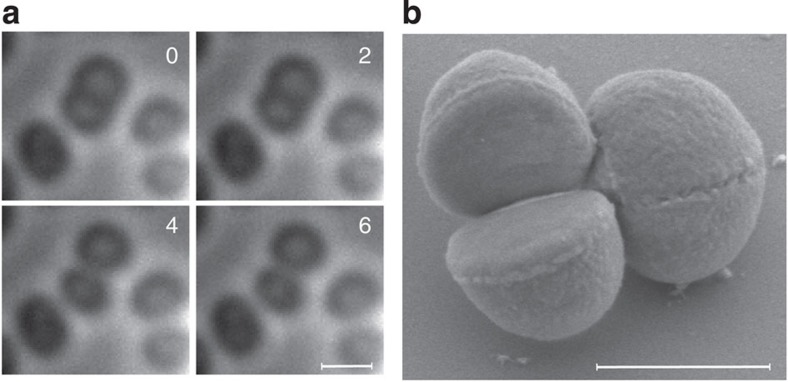
Splitting of S. aureus cells occurs on the millisecond timescale.(a) Dividing S. aureus cells were imaged on an agarose pad, acquiring frames every 2 ms, showing that splitting of the mother cell occurs in <2 ms (between the 2 ms and the 4 ms frame). Time is indicated in milliseconds. Scale bar, 1 μm. (b) To capture intermediate stages in the splitting process, S. aureus cells were fixed with glutaraldehyde during growth and imaged by SEM. The cell on the left has just divided in two daughter cells. The previous division septum is seen as a smooth flat surface indicating that septum splitting and reshaping into a curved hemisphere are likely to be sequential events. Note that cells with flat septa were not as rare as could be expected given the speed of the splitting process. It is therefore possible that the cell treatment required for SEM stabilizes this stage. Scale bar, 750 nm.